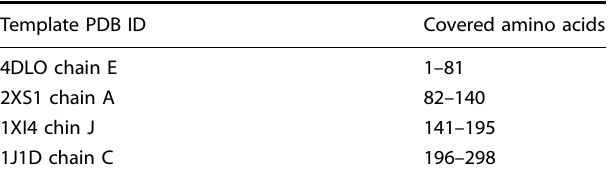
Table 1. Template structures and amino acid sequences used to model human cardiac